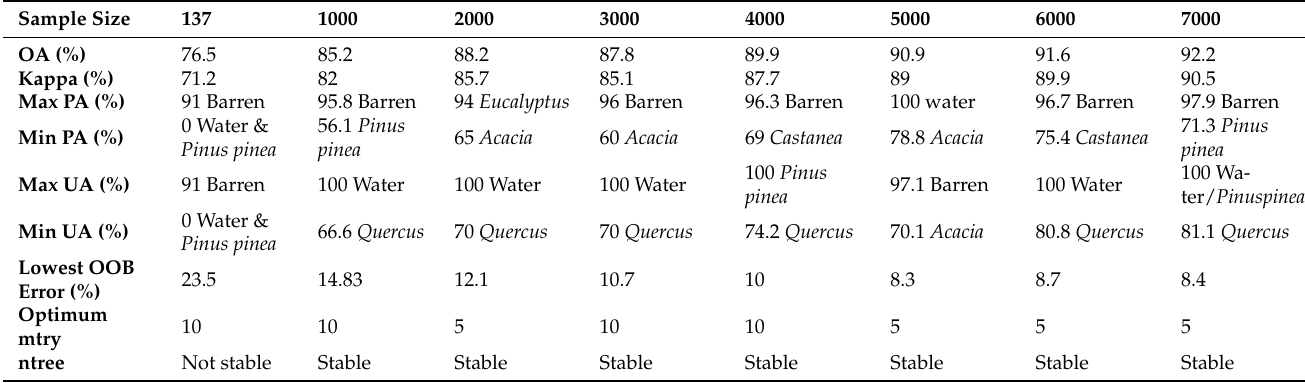
Table A3. Effect of sample size on OA, UA, PA, and Kappa in RF